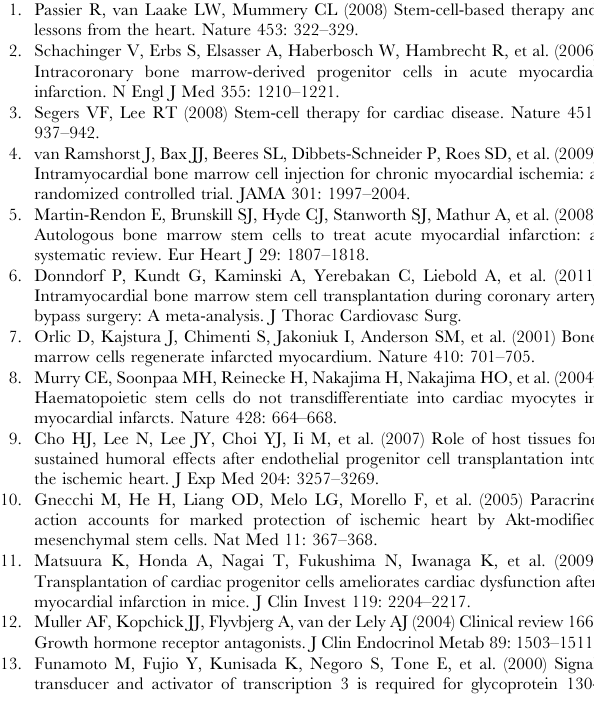
Gr-1( + ) cell-derived CM improved FS (left) and + dp/dt (right) in wild-DOX mice ( n =5) at 1 d after infusion, but not in STAT3dn- DOX ( n =5). Data are means 6 s.e.m. (TIF) Figure S9 Serum activin A concentrations ( n = 5). Data are means 6 s.e.m. (TIF) Figure S10 TNF a increases the secretion of activin A from PBMNC via NF k B. (A) Activin A levels in CM from PBMNC were upregulated by treatment with TNF a ( n = 5). (B) TNF a (50 ng/ml) activated NF k B in PBMNC ( n = 5). Left, total NF k B; right, phosphorylated NF k B. (C) TNF a (50 ng/ml) -mediated upregulation of activin A in PBMNC was inhibited by treatment with the NF k B inhibitory peptide ( n = 5). Isotype peptide was used as control. Data are means 6 s.e.m. (TIF) Table S1 Characteristics of human subjects.